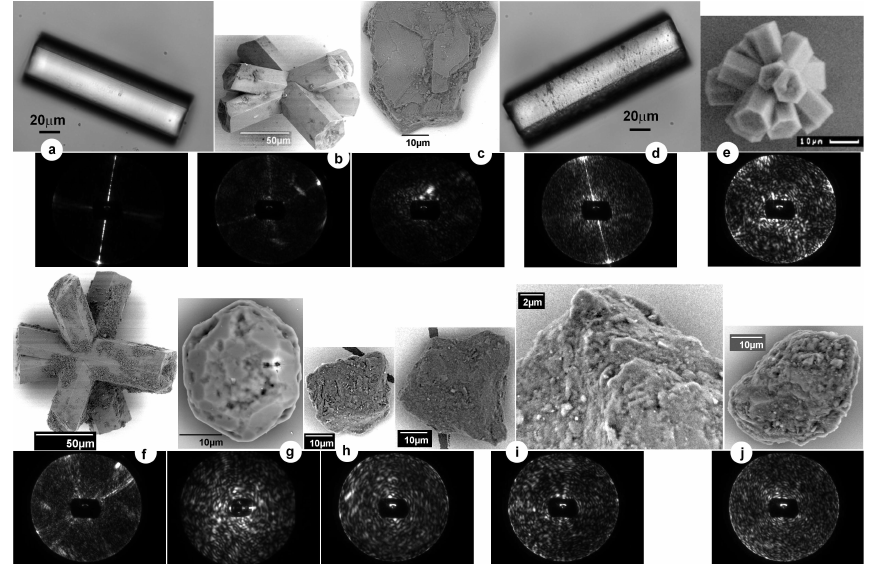
Fig. 7. Upper rows: images of test particles from optical microscopy (ice analogue columns (a) and (d) only) or SEM, labelled with the ID letters from Table 3, with size scales shown in insets – note that the magnifications vary; the dust grain (i) is shown in two magnifications. Lower rows: corresponding SID-3 scattering patterns. Table 2. Significance tests for differences between the roughness measures of ice crystals in the three cloud cases shown in Fig. 6 (marine cirrus, continental cirrus, mixed phase), obtained using the t test method. Shown are the probabilities that the null hypothesis of no difference between the measures is true (low probabilities correspond to more significant differences). Values < 5% are given in bold to highlight significant differences. log